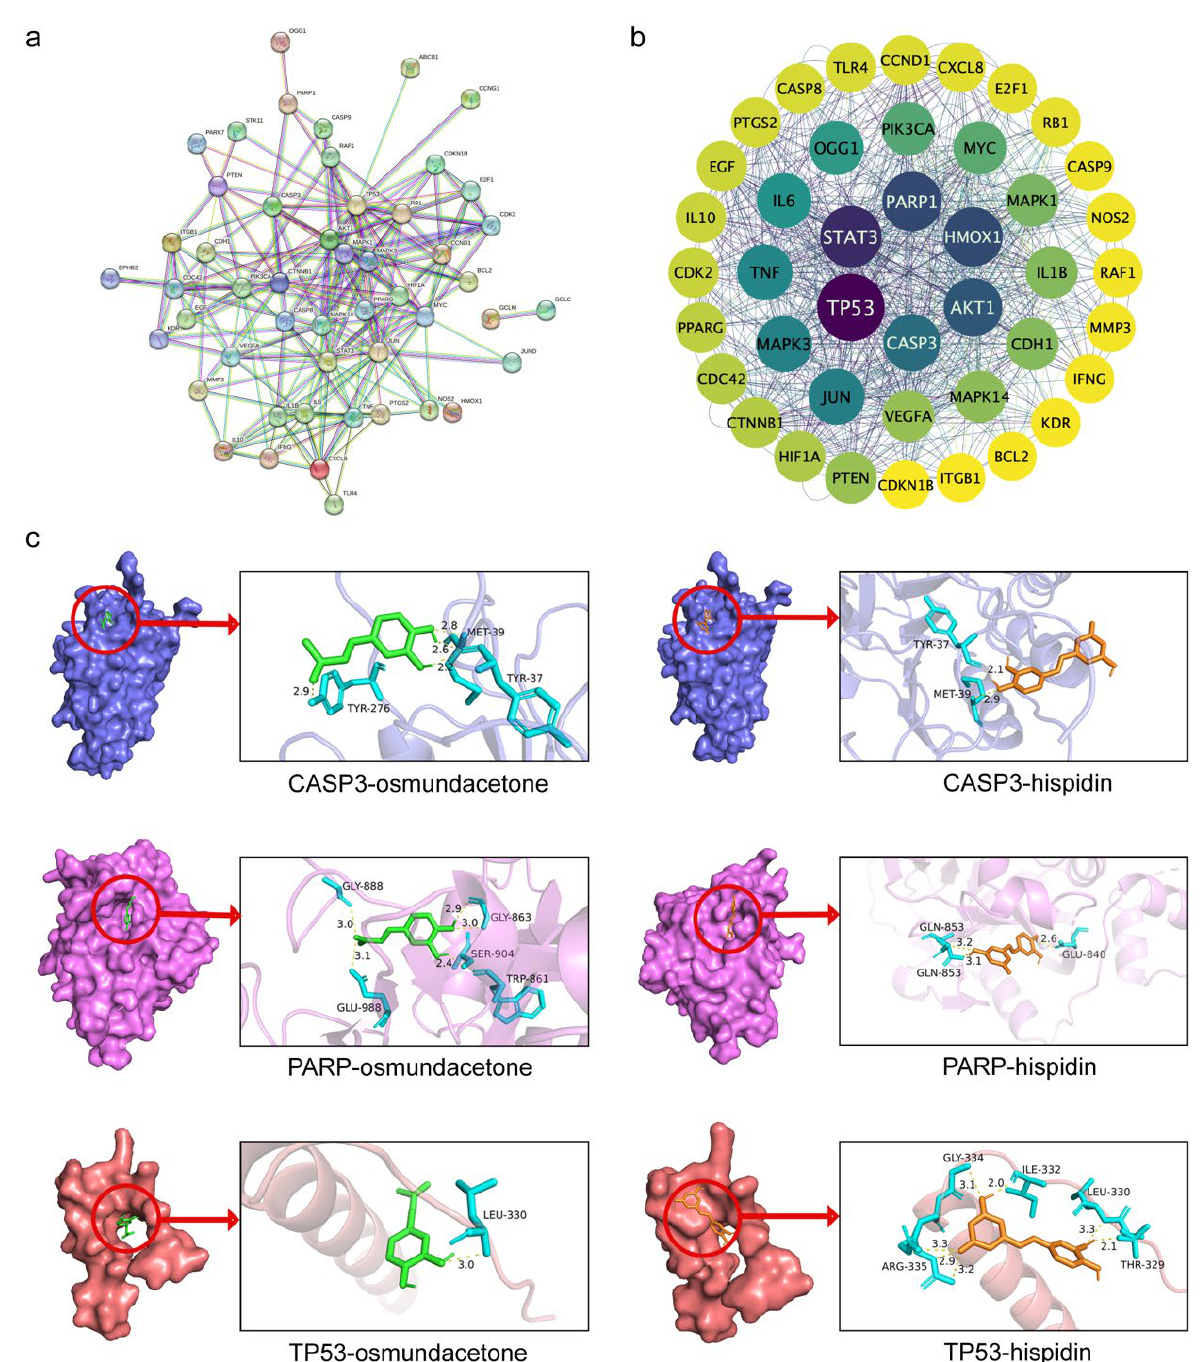
Figure 4. Identification and molecular docking verification of PBP anti-lung cancer core targets. ( a )